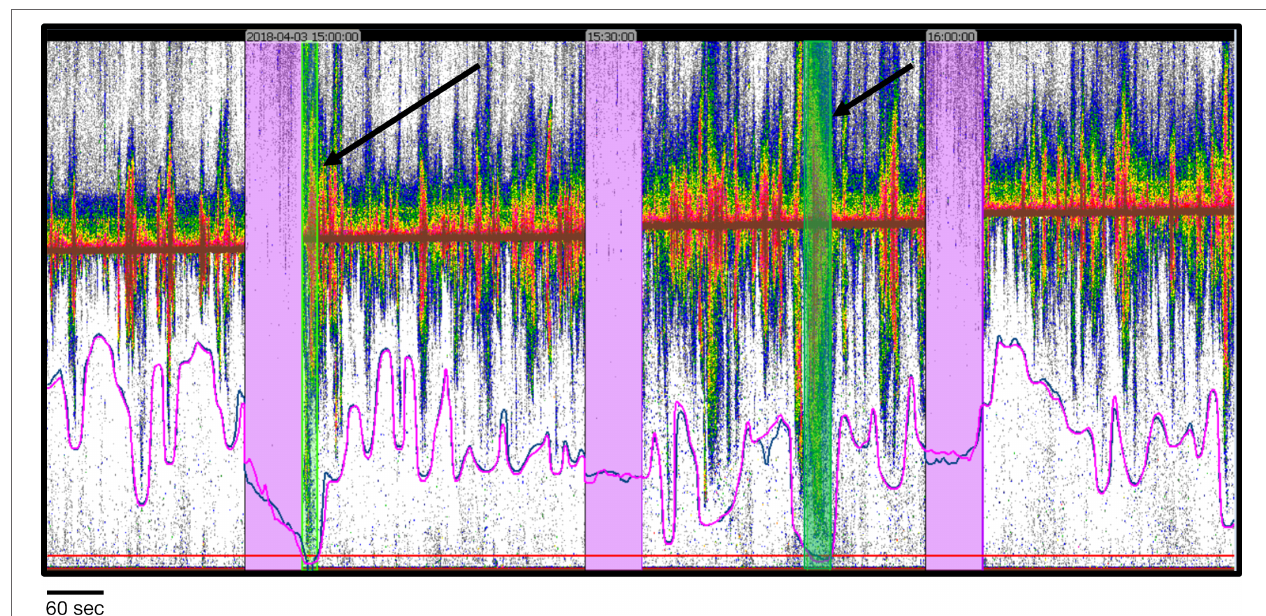
FIGURE 8 | Example of passive data regions (pink bars) and bad data periods (green bars) defined by Echofilter. Echofilter successfully identified the contiguous pings of passive data collection. Bad data periods designated by Echofilter were pings where the entrained-air line (pink or blue lines in this example) intersects with the bottom analytical line (in this case the line designating the outer boundary of the transducer nearfield). Although these cases meet the criteria, in each case the hydroacoustic analyst would designate the entire recording period as a bad data region due to the strength, penetration, and persistence of entrained-air signals. Data: stationary data with echosounder in upfacing orientation, active data recorded for 5 minutes and passive data for one minute every half hour at the Minas Passage